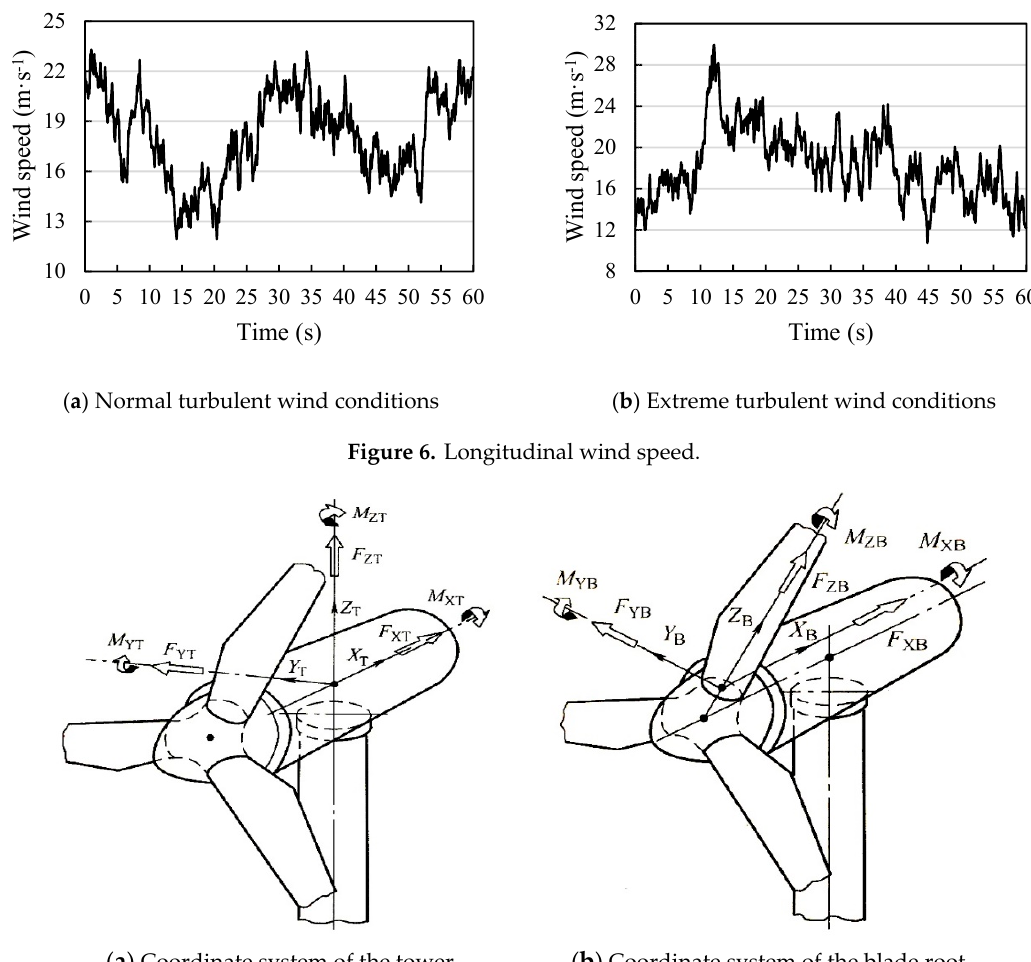
Figure 7. Coordinate systems for wind turbine loads analysis.